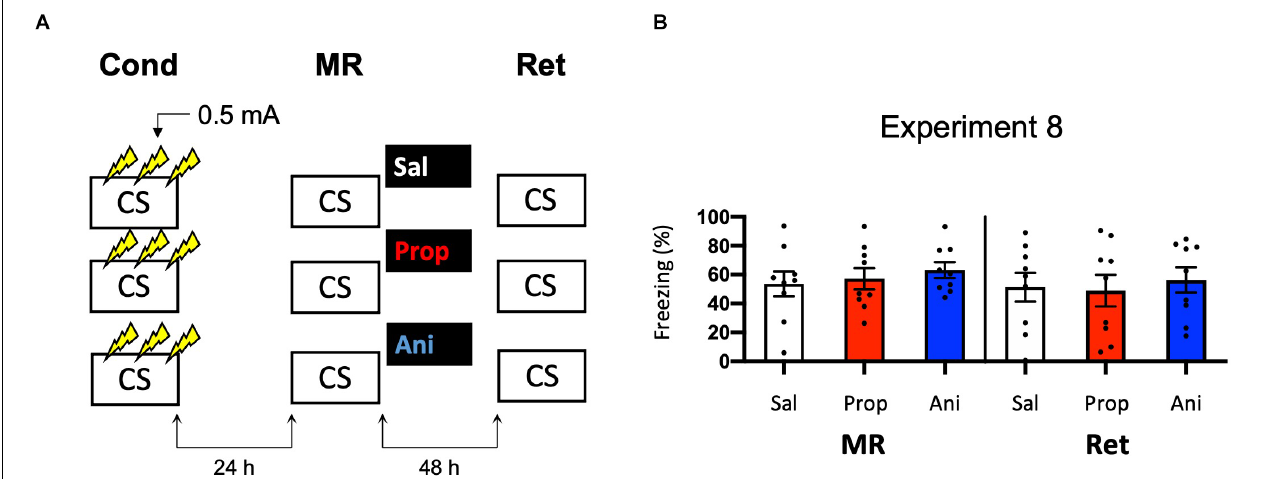
FIGURE 8 | No effect of propranolol or anisomycin on reactivated memories that were acquired with three 0.5 mA shocks during contextual fear conditioning. (A) Design of Experiment 8. Mice received three 0.5 mA shocks during fear conditioning. One day later, mice received saline ( n = 9), propranolol ( n = 9), or anisomycin ( n = 9) after memory reactivation. Forty-eight hours afterward, retention of contextual fear was assessed. Cond, conditioning; MR, memory reactivation; Ret, retention; CS, conditioned stimulus (context); Sal, saline; Prop, propranolol; Ani, anisomycin. (B) Results of Experiment 8. Average percentage of freezing during memory reactivation is displayed on the left, and freezing during the retention test on the right panel of the column chart (saline in white bars, propranolol in red bars, and anisomycin in blue bars). Error bars represent SEM. Filled circles indicate individual